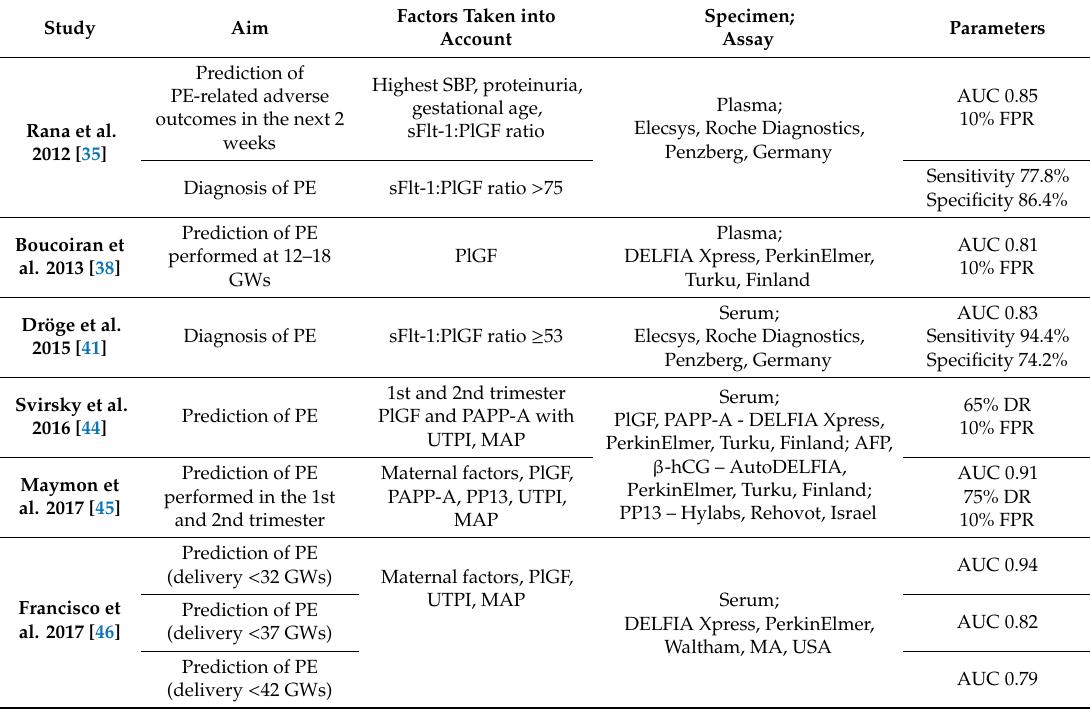
Table 4. Proposed algorithms for the detection of PE in twin